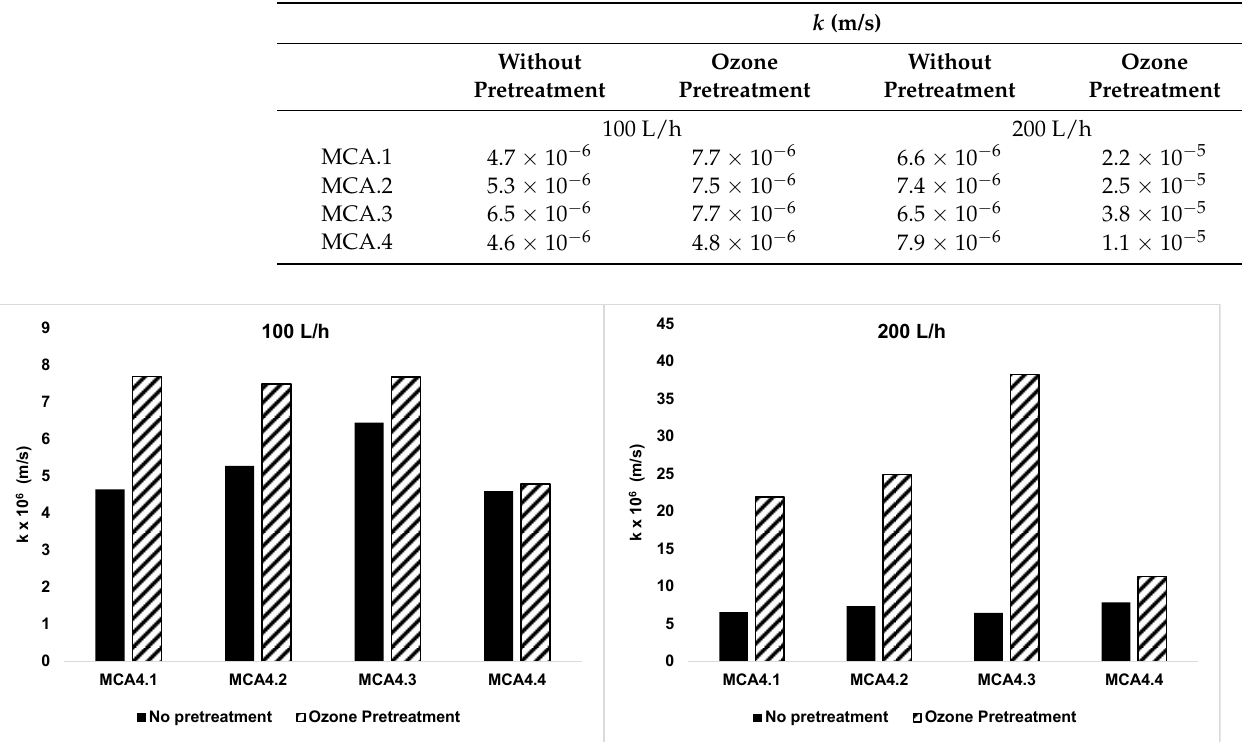
Figure 3. Representation of k vs. membrane type in pretreated and non-pretreated effluents for feed flowrates of 100 and 200 L/h. Table 3. Mass transfer coefficient for each membrane, k , feed flowrate, and with or without ozone pretreatment.